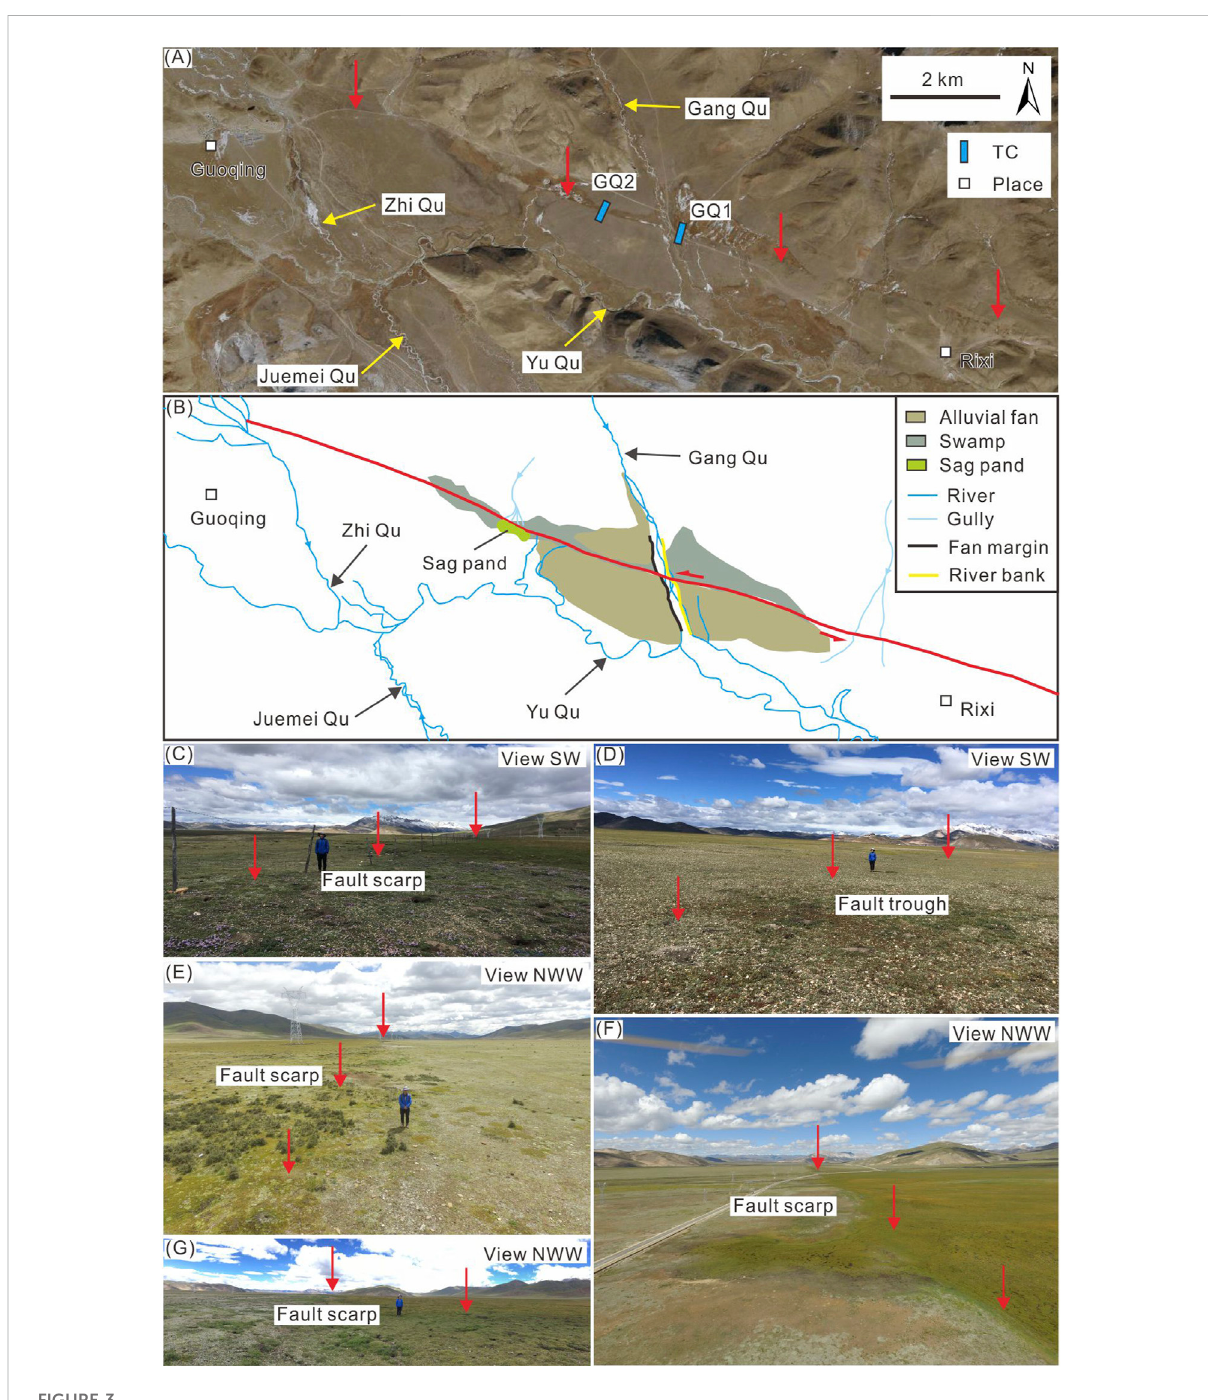
FIGURE 3 Fault traces and faulted landforms near the Guoqing township and the locations of trenches GQ1 and GQ2. (A) Satellite image and (B) interpreted map of the offset landforms near the Guoqing township. The location is shown in Figure 2. The red arrows and lines point to the surface traces of the fault. (C – G) Field photographs of the fault traces and representative faulted